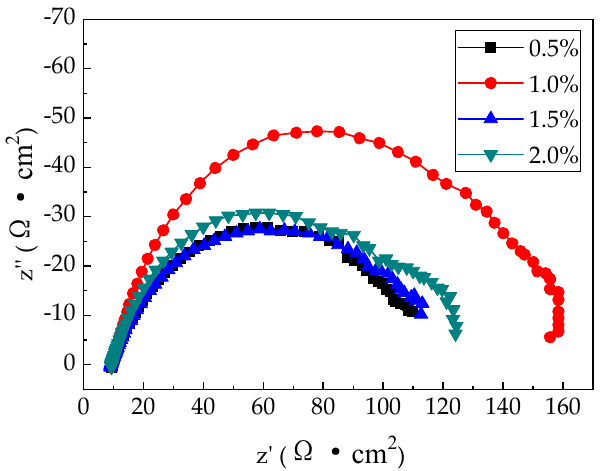
Figure 6. EIS diagram measured on 20 # steel in oil-water flow under different sand concentrations.